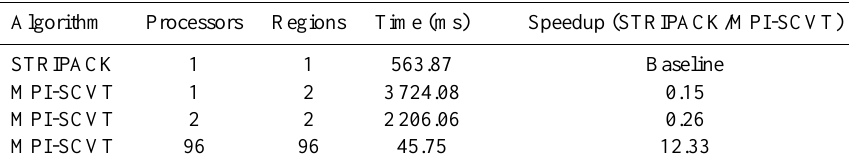
Table 2. Comparison of STRIPACK with serial and parallel versions of MPI-SCVT for computation of a full spherical triangulation. Com- puted using the same initial conditions for a medium resolution grid.